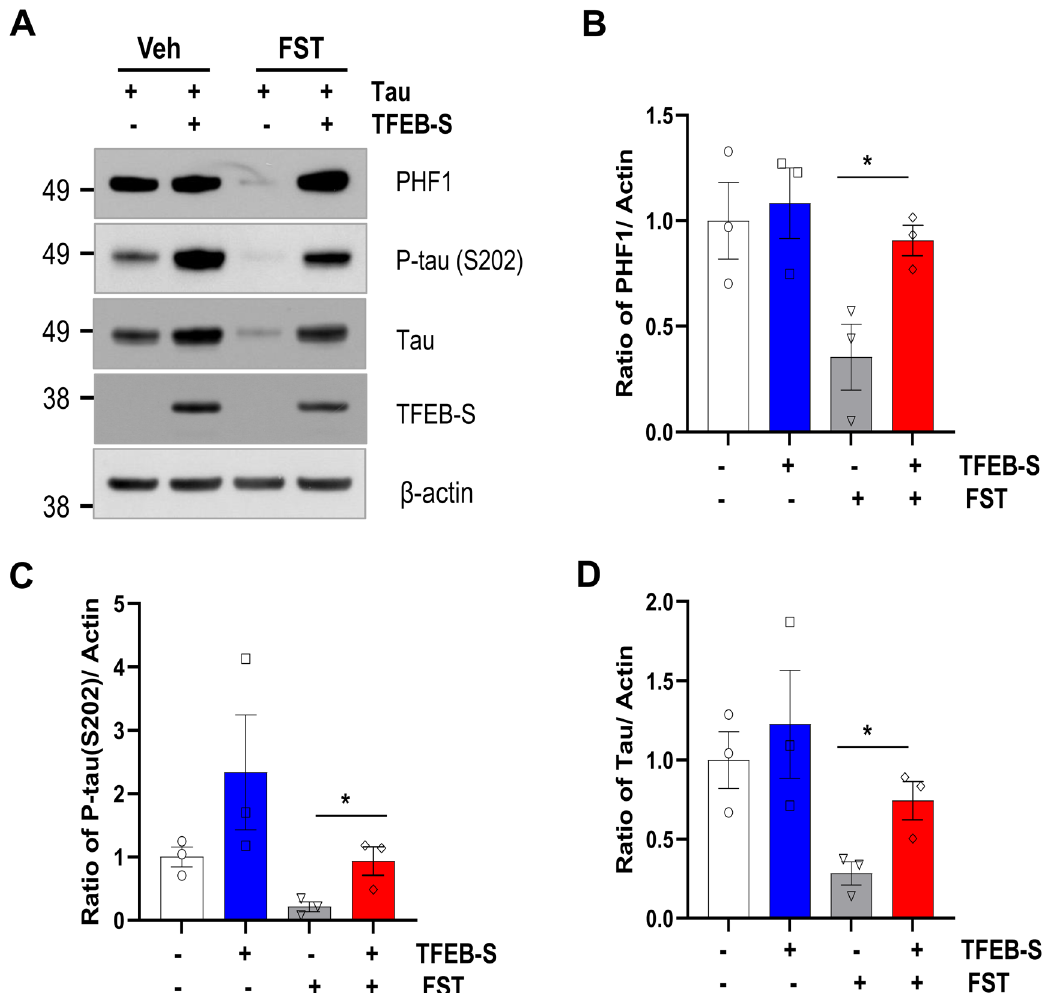
Figure 7. Small TFEB inhibits fisetin-induced clearance of phosphorylated tau. HEK293 cells were transiently co-transfected with the plasmid expressing tau and either the plasmid expressing small TFEB or an empty vector. The cells were treated with 10 μM fisetin for 12 h. ( A ) The protein levels of PHF1, phospho-tau (S202), total tau, small TFEB (TFEB-S), and actin were analyzed by immunoblotting using anti-PHF1, anti-phospho-tau (P-tau, S202), anti-tau, anti-HA and anti-actin antibodies, respectively. Full blots are provided in Supplementary Fig. S6. ( B – D ) Bar graphs represent the relative ratio of PHF1 ( B ), phospho-tau (S202) ( C ), and total tau ( D ) normalized with that of actin. The data are shown as the mean ± S.E. of three independent experiments and were analyzed using Student’s t test. (* p <